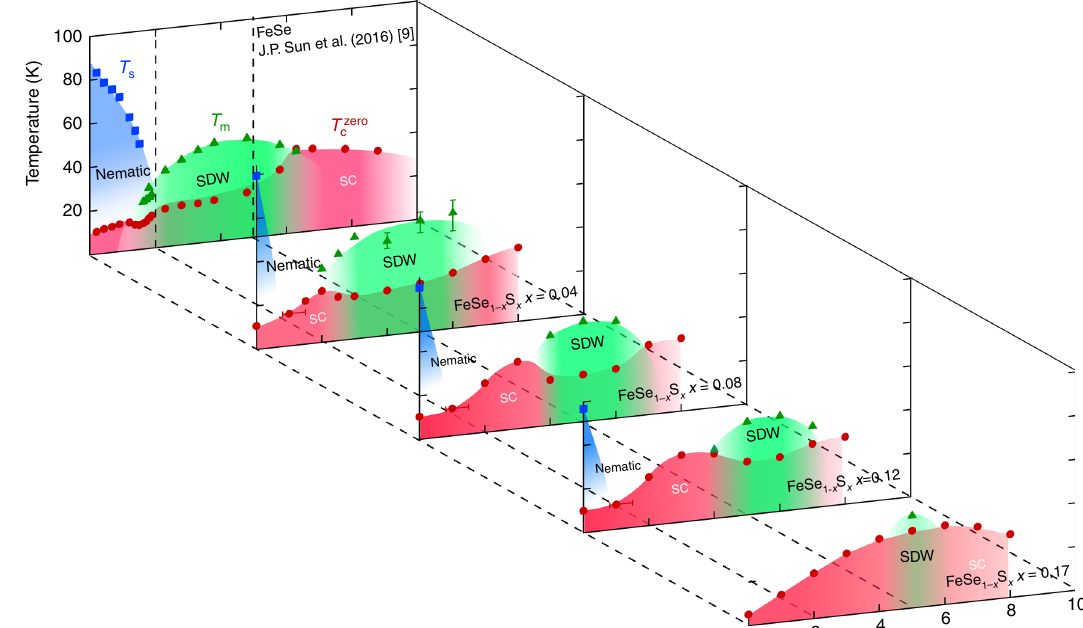
Fig. 1 Temperature-pressure-concentration phase diagram in FeSe 1 − x S x . The structural ( T s , blue squares), magnetic ( T m , green triangles) and superconducting transition temperatures ( T zero , red circles) are plotted against hydrostatic pressure P and S content x . Following the procedure reported for c x = 0 by Sun et al. 9 , T T T zero are de fi ned respectively by the temperatures of upturn, kink and zero resistivity in ρ ( T ) curves measured in the s , m and c constant-loading type cubic anvil cell for x = 0.04, 0.08, 0.12 and 0.17 (Supplementary Figs. 3 – 6). The errors of T m , are estimated from the broadness of the kink anomaly in ρ ( T ). The cell is optimized for the high-pressure range, and thus for P < 2 GPa the error of pressure is relatively large (see error bars for 1 GPa) compared to higher pressures. The colour shades are the guides for the eyes. Detailed phase diagrams for constant x and P are shown in Supplementary Figs. 1, 2,